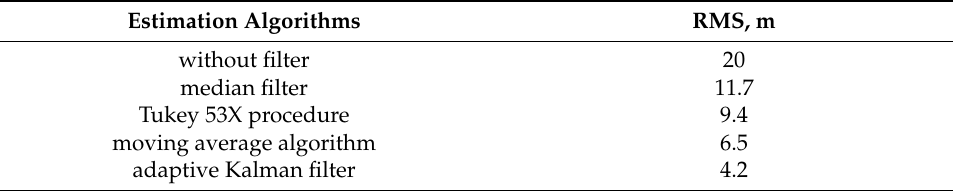
Table 1. Positioning accuracy of different estimation